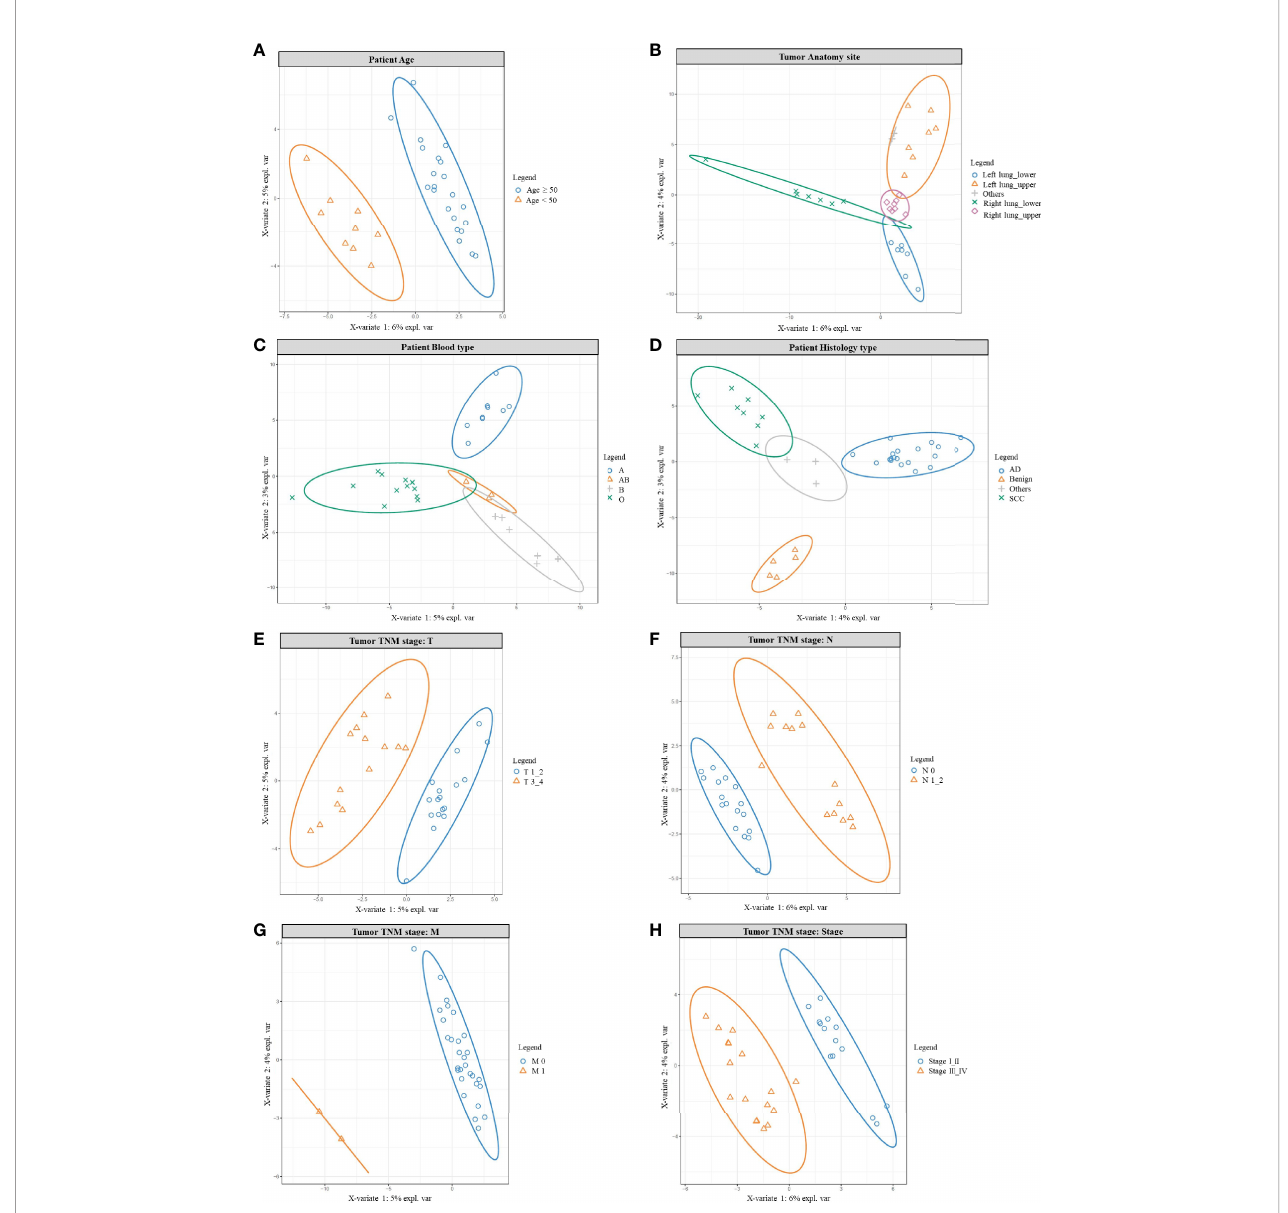
FIGURE 3 | PLSDA results for age, anatomy site, blood type, histology, and TNM stage. PLSDA analysis for patients ’ age (A) , anatomy site (B) , blood type (C) , histology type (D) , and TNM stage: T stage (E) , N stage (F) , M stage (G) , Tumor stage (H) . The combined normal/cancer tissue data from one patient were used to generally represent the microbiome of the